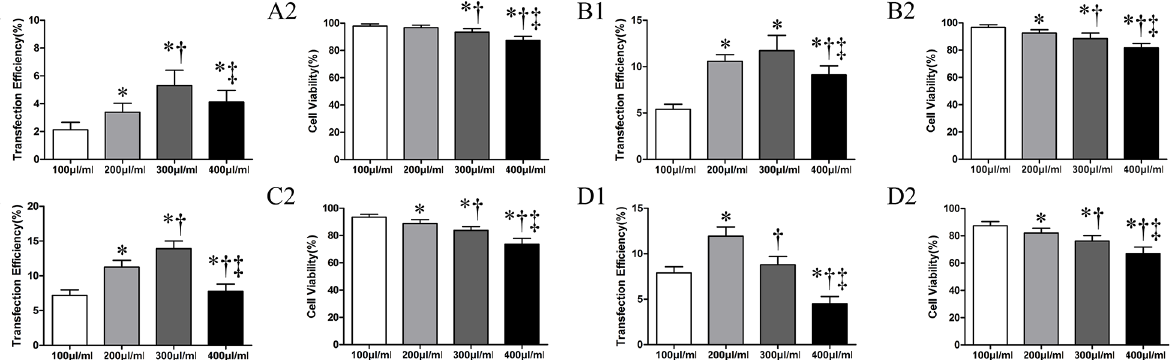
Fig 2. Effects of AI and MC on cell transfection efficiency and cell viability. (A1-A2): transfection efficiency and cell viability at different MC (100 μ l/ml, 200 μ l/ml, 300 μ l/ml and 400 μ l/ml) when AI was 0.5W/cm 2 . (B1-B2): transfection efficiency and cell viability at different MC (100 μ l/ml, 200 μ l/ml, 300 μ l/ml and 400 μ l/ml) when AI was 1.0 W/cm 2 . (C1-C2): transfection efficiency and cell viability at different MC(100 μ l/ml, 200 μ l/ml, 300 μ l/ml and 400 μ l/ml) when AI was 1.5W/cm 2 . (D1-D2) transfection efficiency and cell viability at different MC (100 μ l/ml, 200 μ l/ml, 300 μ l/ml and 400 μ l/ml) when AI was 2.0 W/cm 2 . Indication: Symbols indicate significant differences ( P < 0.05) from the 100 μ g/ml. ( * ), from 200 μ g/ml ( † ) and from 300 μ g/ml ( ‡ )respectively.